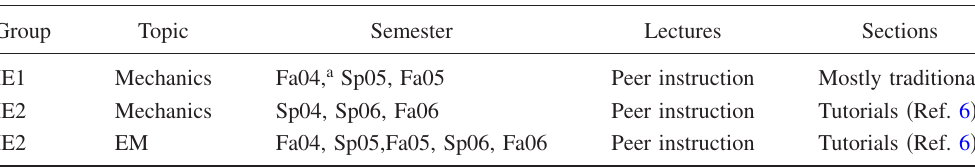
TABLE I. Summary of the introductory physics courses included in the study.